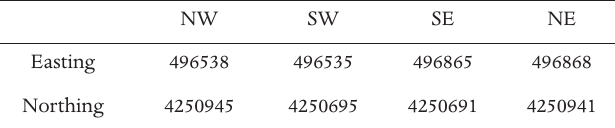
Table 4. Final UTM WGS 1984 pairs of coordinates for the four quoted corners reported in the maps of Bukumirovic et al. [1997]; values refer to the 33 S